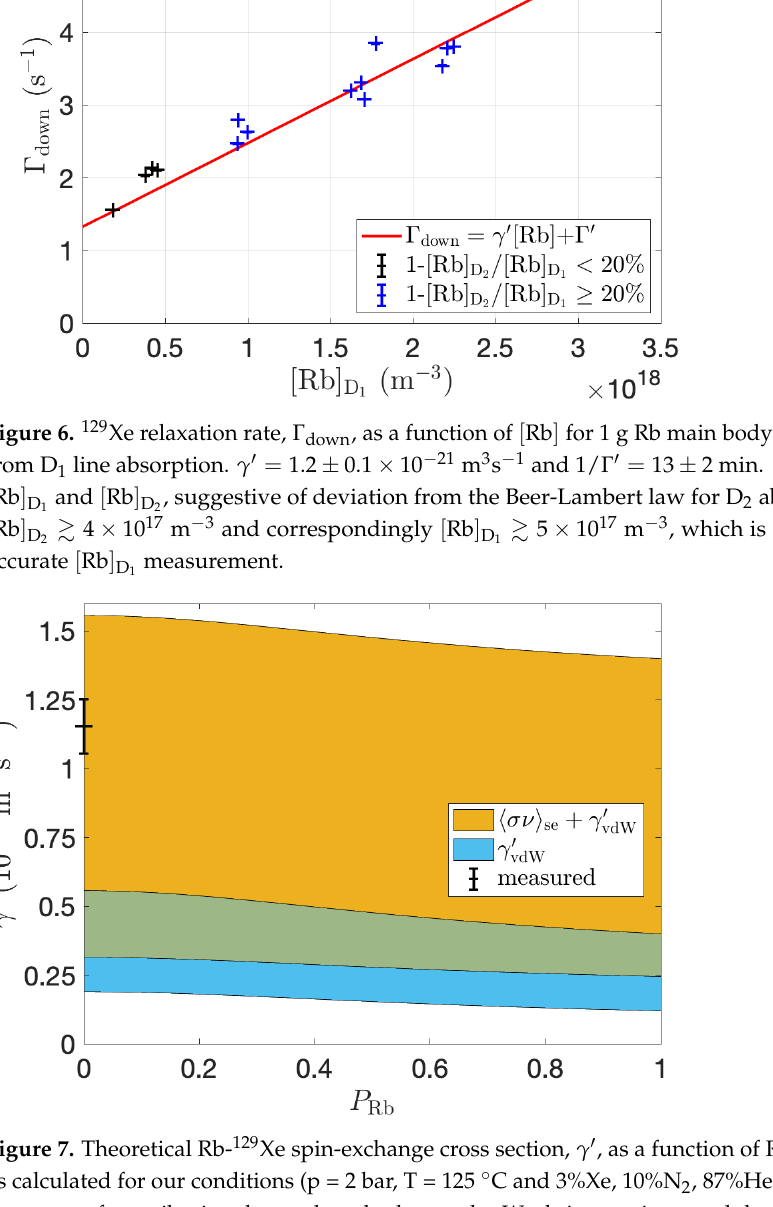
Figure 7. Theoretical Rb- 129 Xe spin-exchange cross section, γ (cid:48) , as a function of Rb polarization, P Rb , as calculated for our conditions (p = 2 bar, T = 125 ◦ C and 3%Xe, 10%N 2 , 87%He). The blue region is the range of contribution due to three-body van der Waals interactions, and the yellow region is the added range of contribution due to measured binary spin-exchange cross sections from the literature. The green region is where the derived ranges of each spin-exchange cross section contribution from the literature overlap. Our measured value is plotted at P Rb = 0, as the optical pumping laser was not on during Γ down